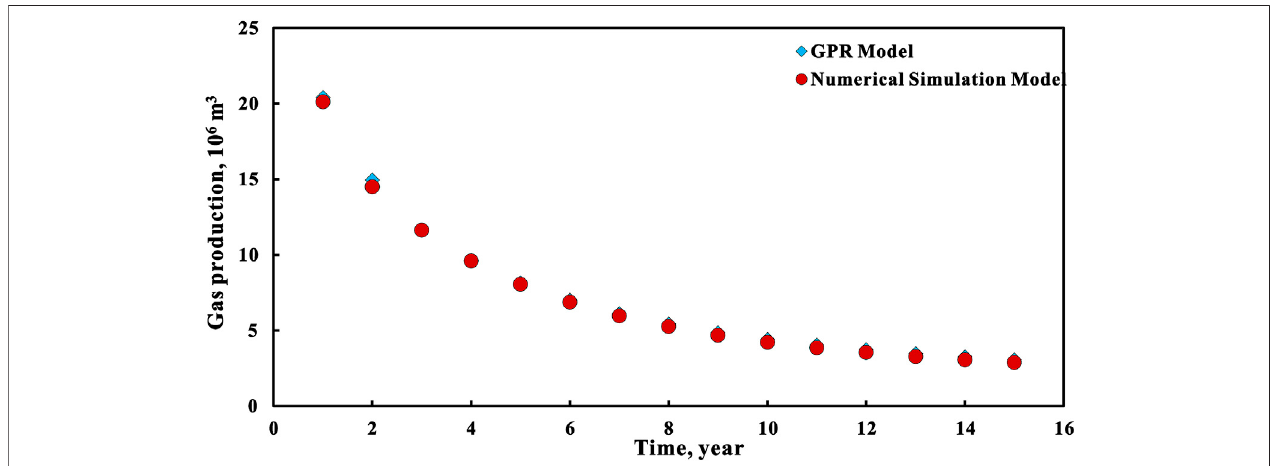
FIGURE 7 | Comparison of production decline curves between GPR model and numerical simulation model.